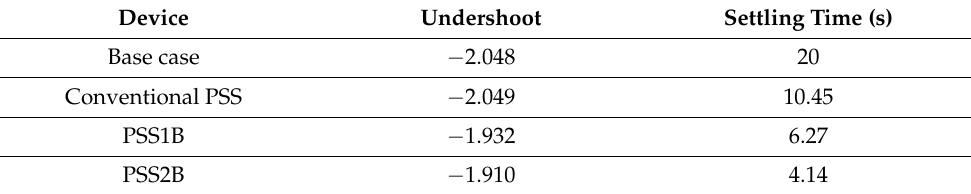
Table 11. Maximum overshoot and settling time of rotor angle deviation at normal loading.